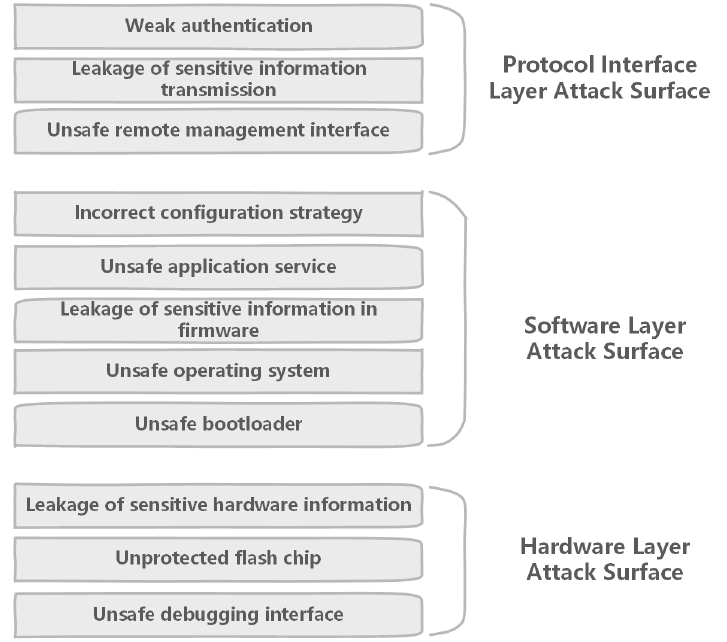
Figure 3. Attack surface of IoT